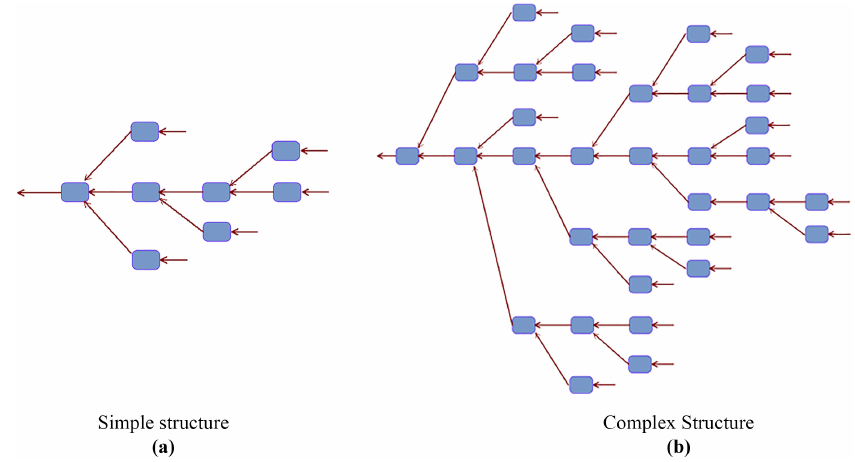
Figure 2. Examples of feed- forward structures; no